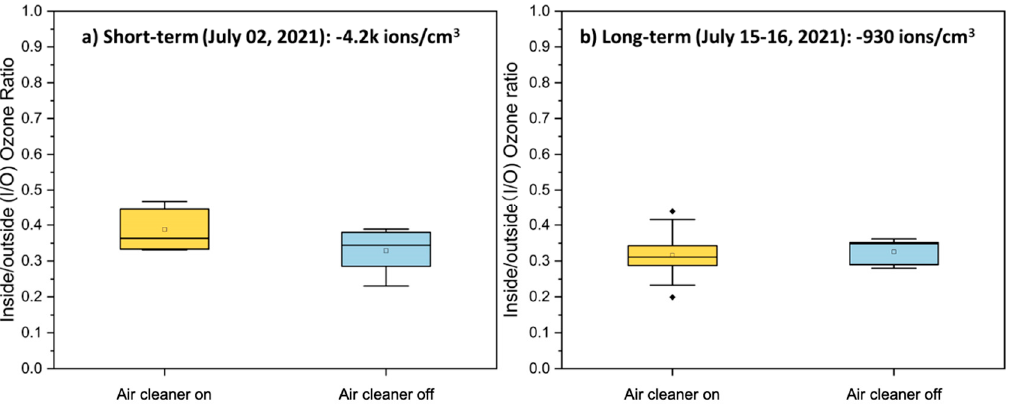
Figure 7. Inside/outside (I/O) chamber ozone concentration ratios measured during two natural condition tests: ( a ) short-term (2 July 2021) and ( b ) long-term (15–16 July 2021). Hollow squares represent mean values and solid diamonds represent outlier values. Table 3. Summary of mean (SD) ozone (O 3 ) concentrations measured inside and outside the cham- ber during three natural condition tests targeting gas-phase organics (VOCs and aldehydes).